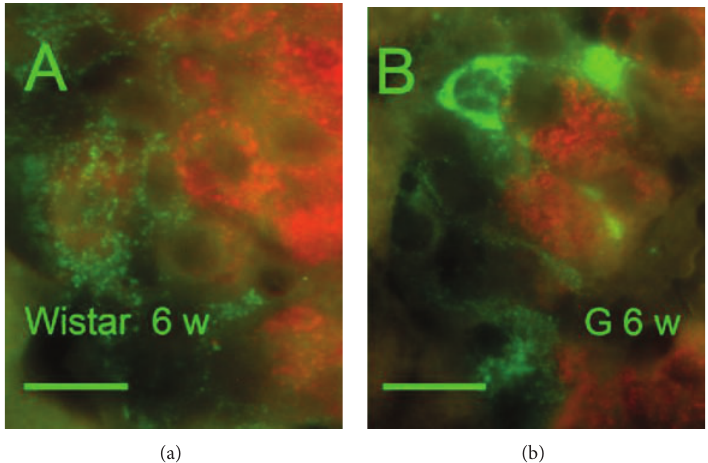
Figure 3: Insulin and somatostatin immunohistochemical pattern in six-week-old rats. Insulin : red , SST: green , and “w”: weeks. Overlay images of pancreatic islets of six-week-old Wistar (a) and Goto-Kakizaki (b) rats “G.” Only a fine granular SST positivity was observed in Wistar controls, whereas, in GK rats, individual or small groups of cells with irregular rough and dense SST positivity could be recorded. Original magnification 1000 × ; scale bars 12.5 𝜇 m.